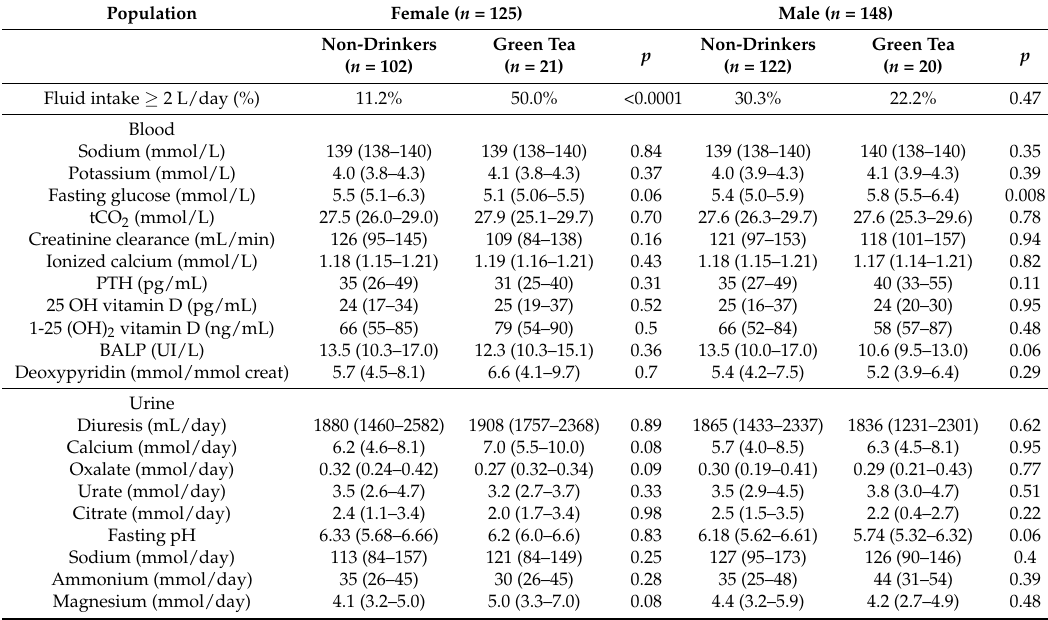
Table 2. Food intake evaluation, biological data, and metabolic risk factors.